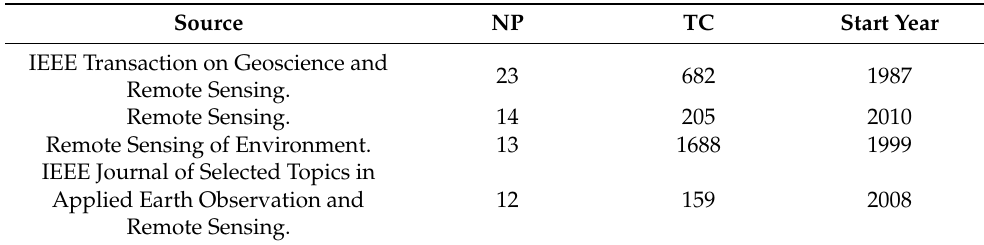
Table 3. Top 20 journals on EOS and PM studies from 1979–2019. Source NP